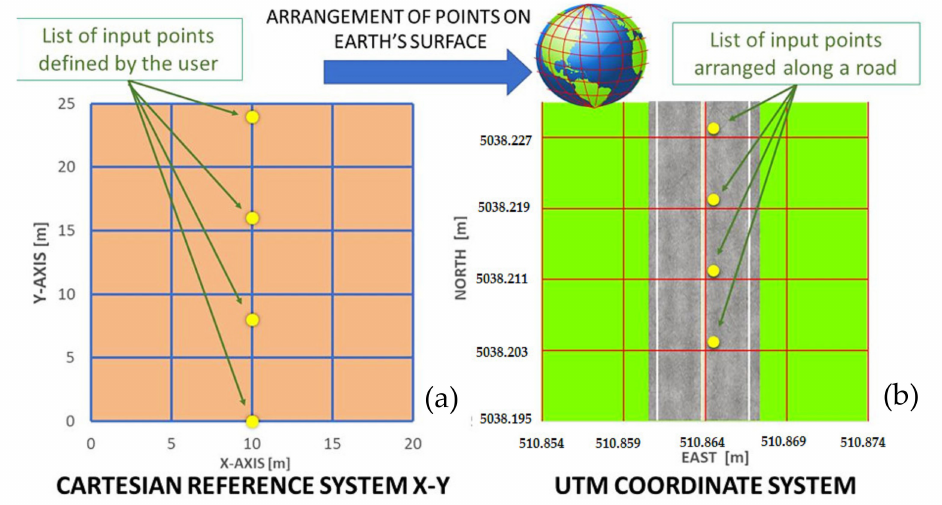
Figure 3. Set of points defined by user in a generic Cartesian reference system with origin x = 0, y = 0 ( a ); through a specific Matlab tool, the input points are arranged on the UTM coordinate system ( b